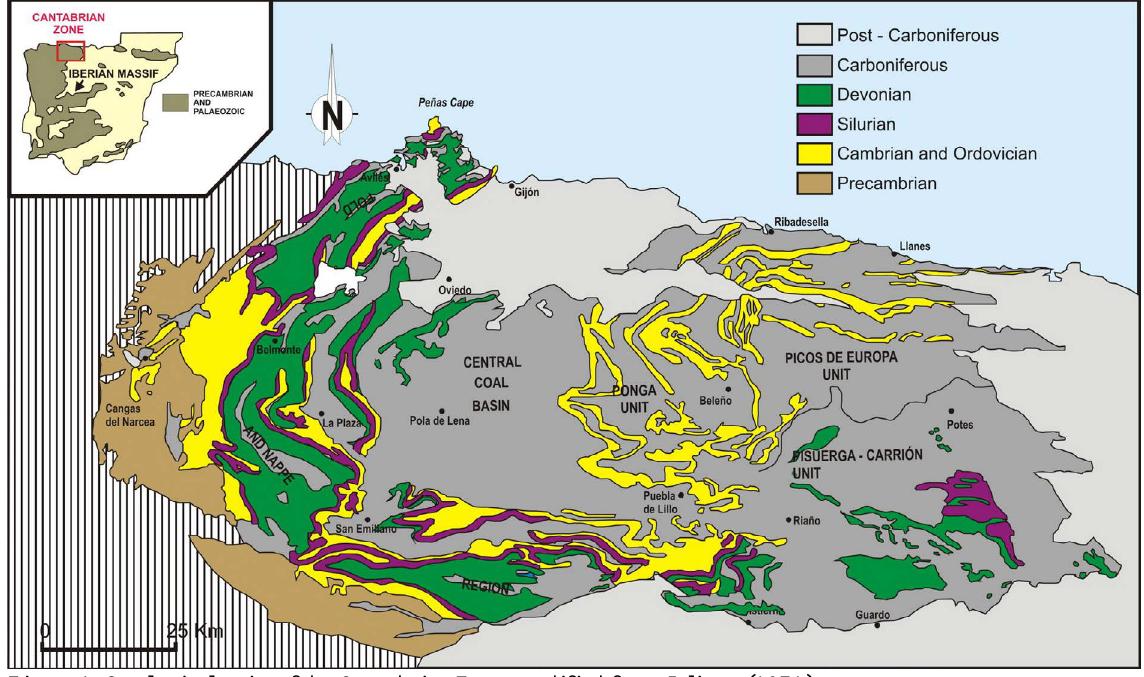
Figure 1: Geological units of the Cantabrian Zone modified from Julivert